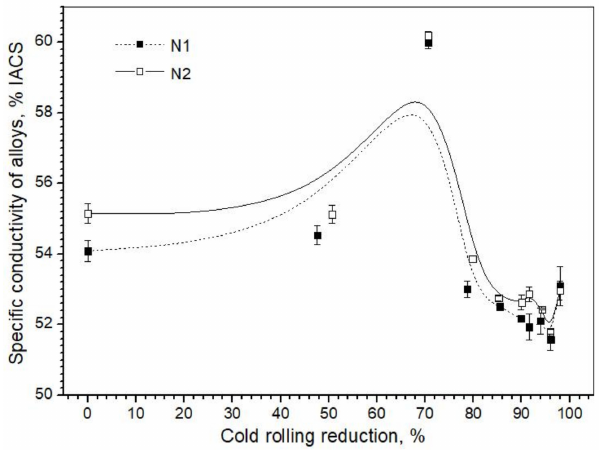
Figure 2. Change in specific